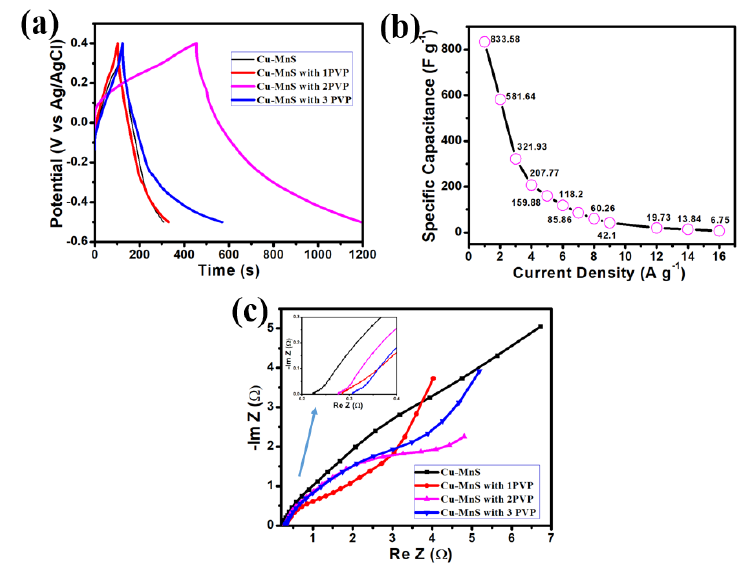
Figure 8. ( a ) Galvanostatic charge–discharge profile of four different electrodes at current density of 1 A g −1 in 2 M KOH solution and ( b ) specific capacitance values calculated from the GCD curves of